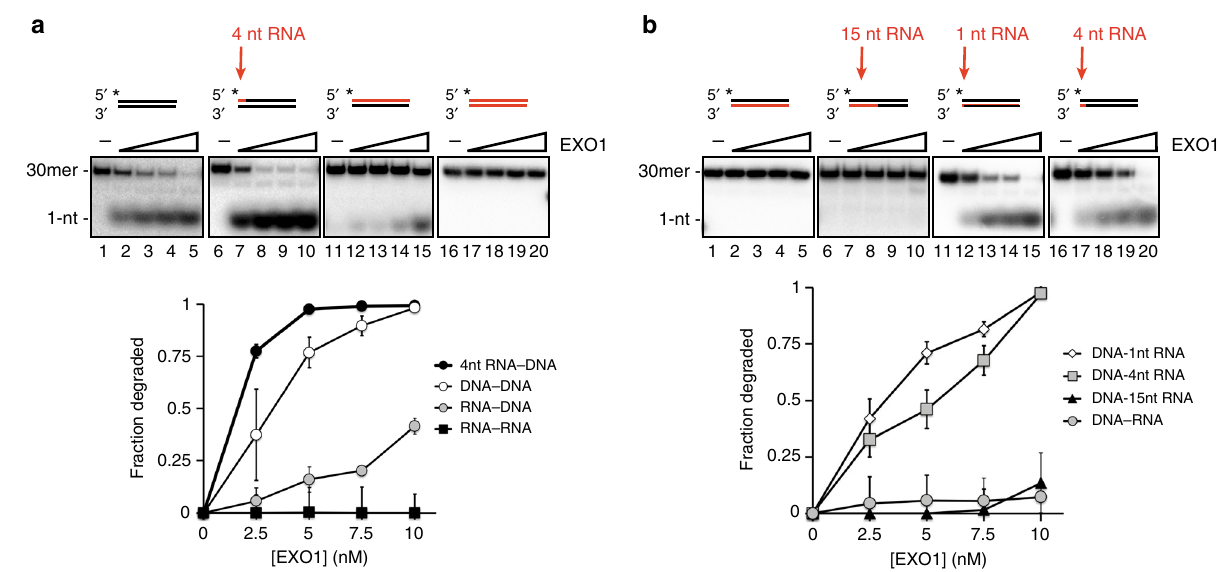
Fig. 2 Effect of ribonucleotides on EXO1 initiation. a The indicated 5 ′ end-labeled substrates were incubated with EXO1 (2.5, 5, 7.5, 10 nM) and reaction mixtures were resolved in a 10% native acrylamide gel. b The indicated 5 ′ end-labeled substrates were tested as in ( a ). Error bars in all the panels represent the standard deviation of results from n = 3 independent experiments, and all points represent the mean. RNA is denoted in red, and the asterisk indicates the location of the